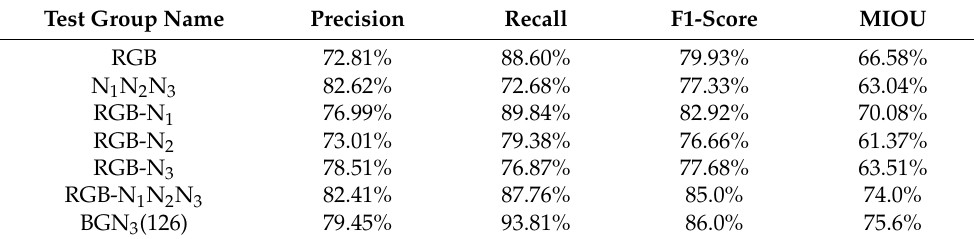
Table 8. Evaluation metrics related to grape image segmentation.